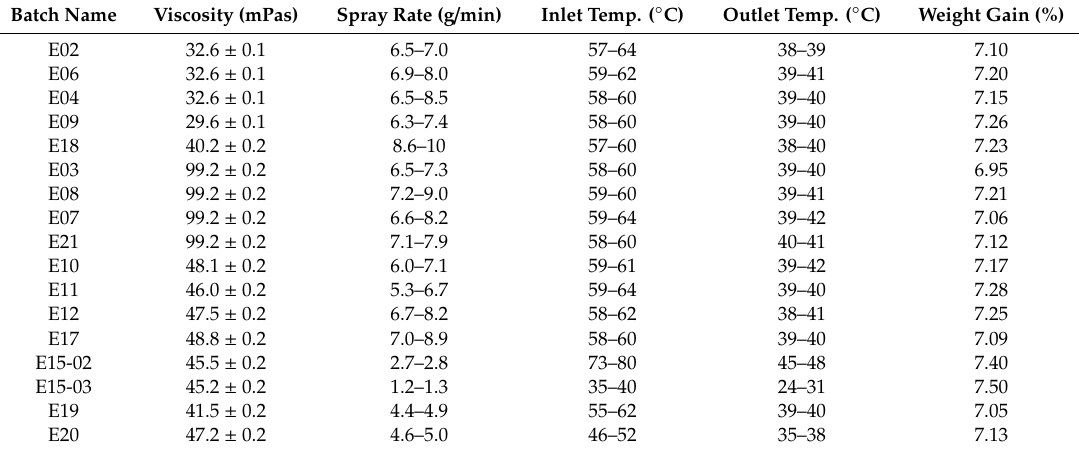
Table 7. Processing parameters for each formulation. The order in the table is given by the type of polymer used, starting with HPMCAS series (E02–E18), followed by HPMCP series (E03–E17) and Eudragit (E15-02–E15-03) and C-A-P (E19–E20). Weight gain is the increase in mass due to applied polymer based on the uncoated filled